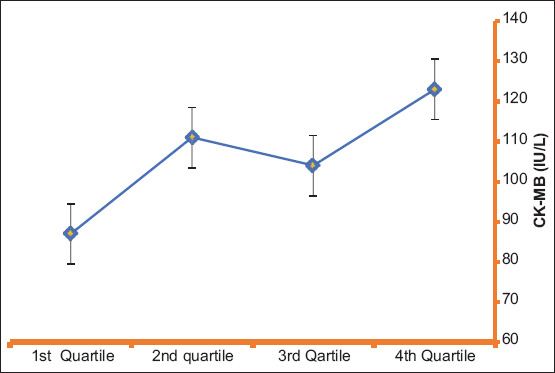
Creatine kinase myocardial band levels stratified per platelet\lymphocyte ratio quartile.